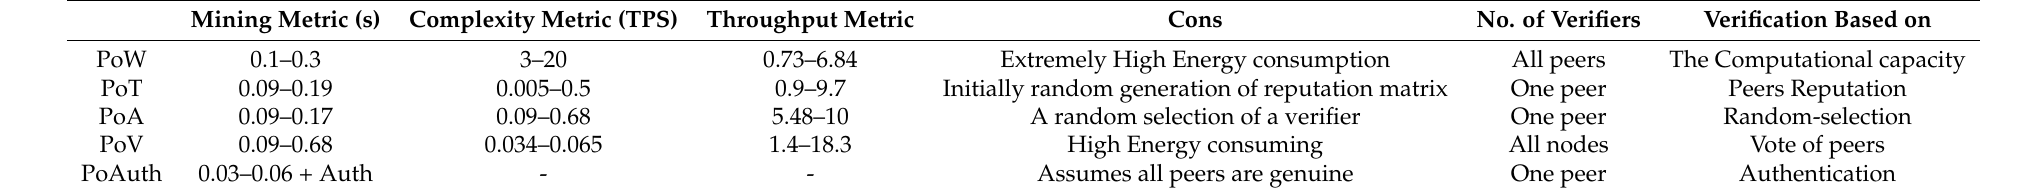
Table 5. Comparisons of the developed consensus